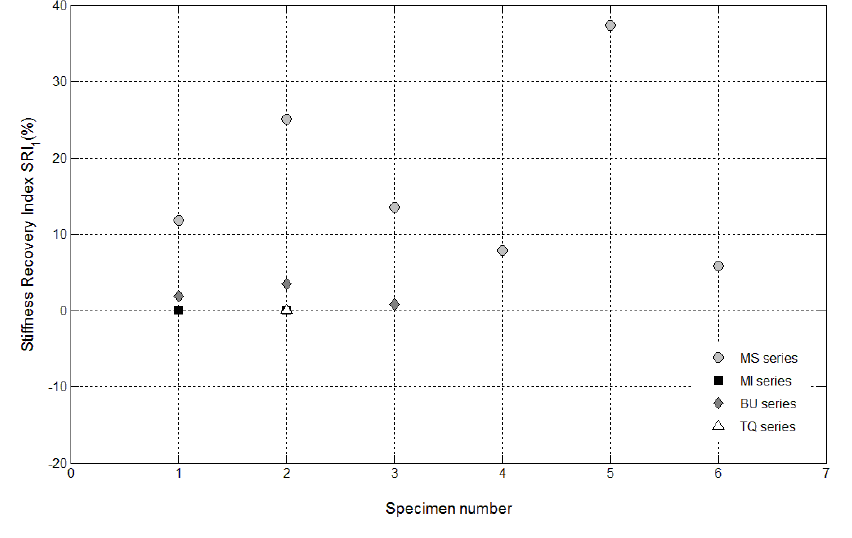
Figure 14. Load recovery indices LRI 1 for control specimens (Samples 1 and 2 belonging to the MI series and Sample 2 belonging to the TQ series) and for self-healing specimens (Samples 1–6 belonging to the MS series and Samples 1–3 belonging to the BU series).